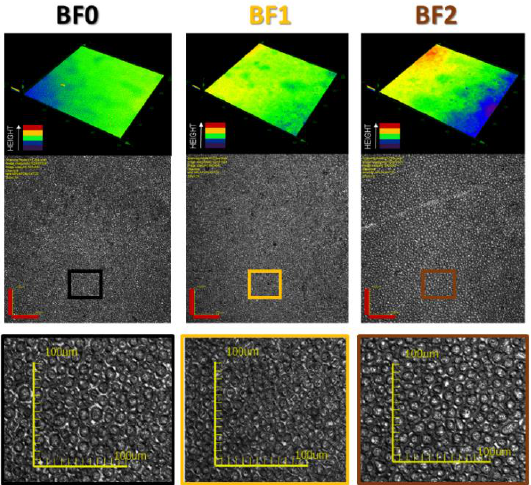
Figure 4. Optical microscope images of the BF0 , BF1, and BF2 samples: height color map and magnification of the selected area (colored square) (scale bar = 100 μm).